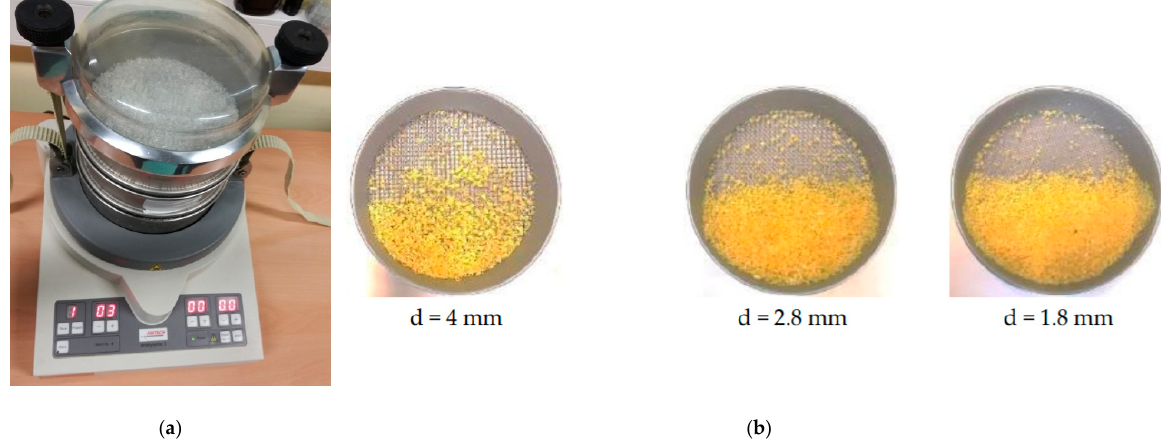
Figure 4. The view of vibratory sieve shaker ( a ) and sieves ( b ) used for the sieve analysis of the mixed plastic waste. Table 1. The percentage share of each fraction in the total mass of polymers investigated after grinding and sieving. Samples